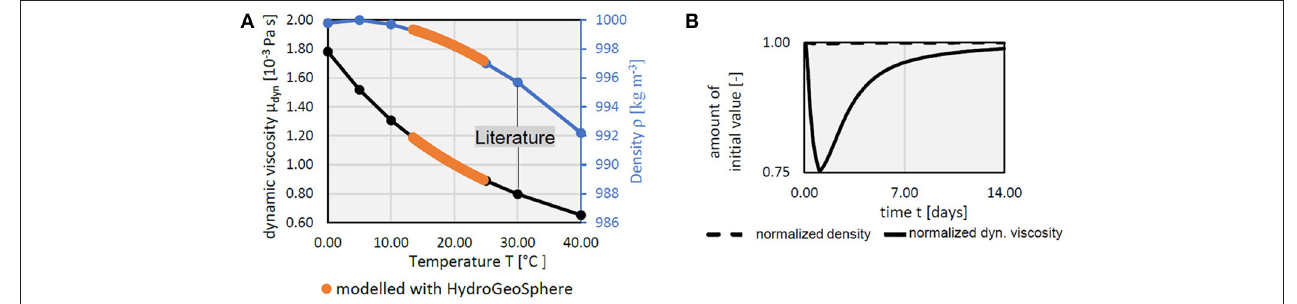
FIGURE 4 | Heat and solute simulation results at the pumping well ignoring any trend (A,B) and considering a downwards increasing K-trend (C,D) compared with the deterministic density-viscosity model. Best heat and solute simulation were used to visualize the complementary tracer (Note that the simulations which consider only the density dependence to temperature and not the viscosity dependence are not shown and rejected as they are not realistic enough).